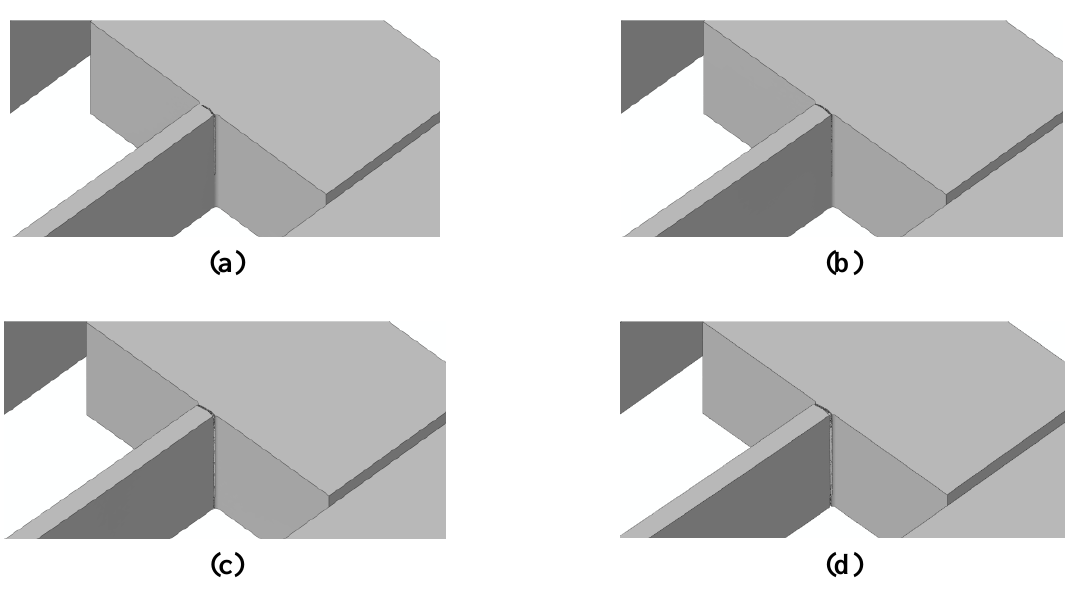
Figure 15. Side-A drop, forecasted crack patterns at time (a) t = 1.18  s, (b) t = 1.19  s, (c) t = 1.20  s, and (d) t = 1.25  s.